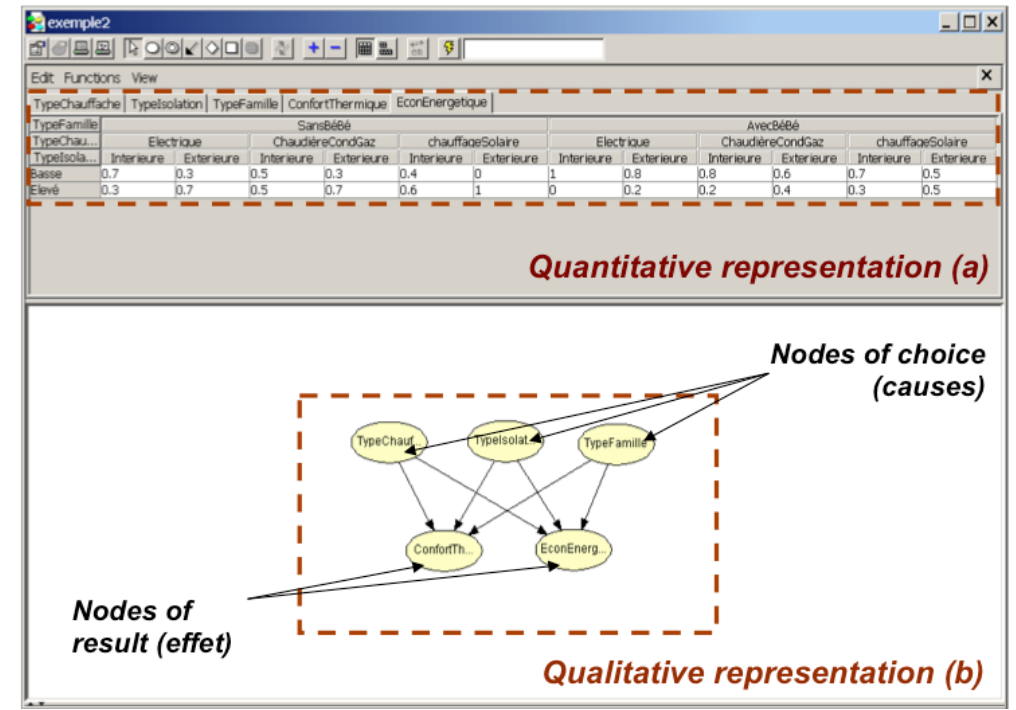
Figure 9. Implementation of a Bayesian network; ( a ) Filled Informations conditional probability tables; ( b ) Graphic description model. Bayesian network interface HUGIN [45].